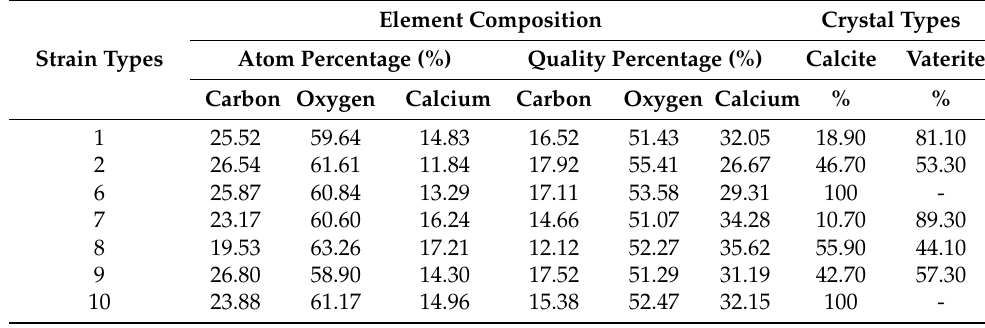
Table 2. Mineral element composition and crystal composition of